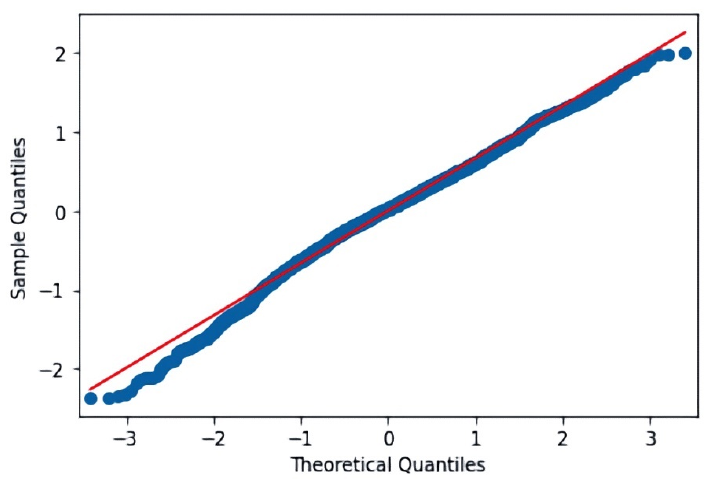
Figure 21. QQ–plot of MANOVA between rill network and forest cover, anthropogenic load, prevailing soil type, and soil ‐ forming rocks.